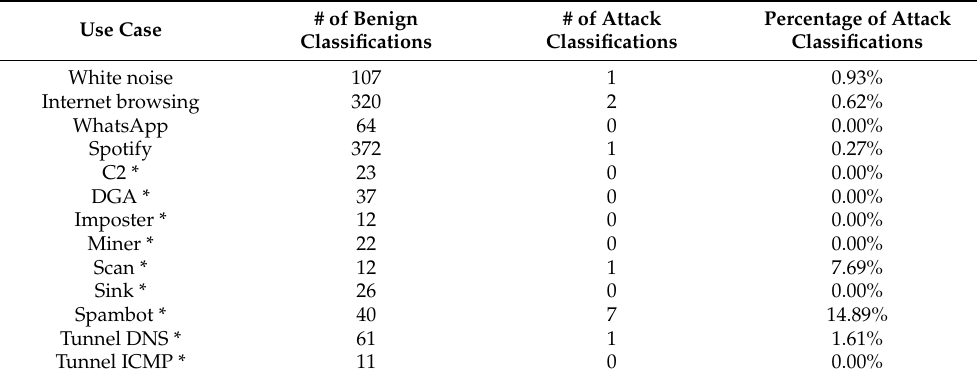
Table 6. Real-world network data captured. Note that attacks are labelled using